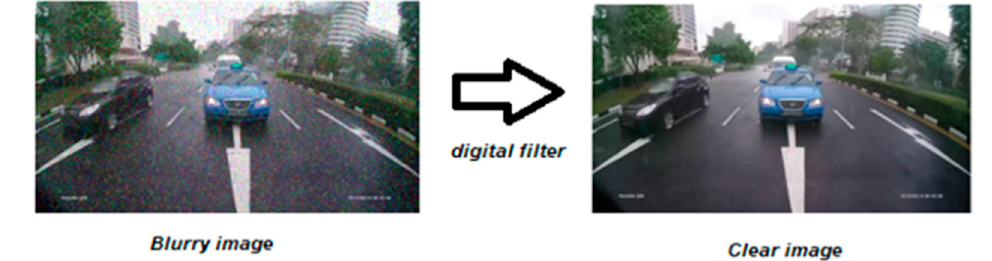
Figure 4. Noise removal.